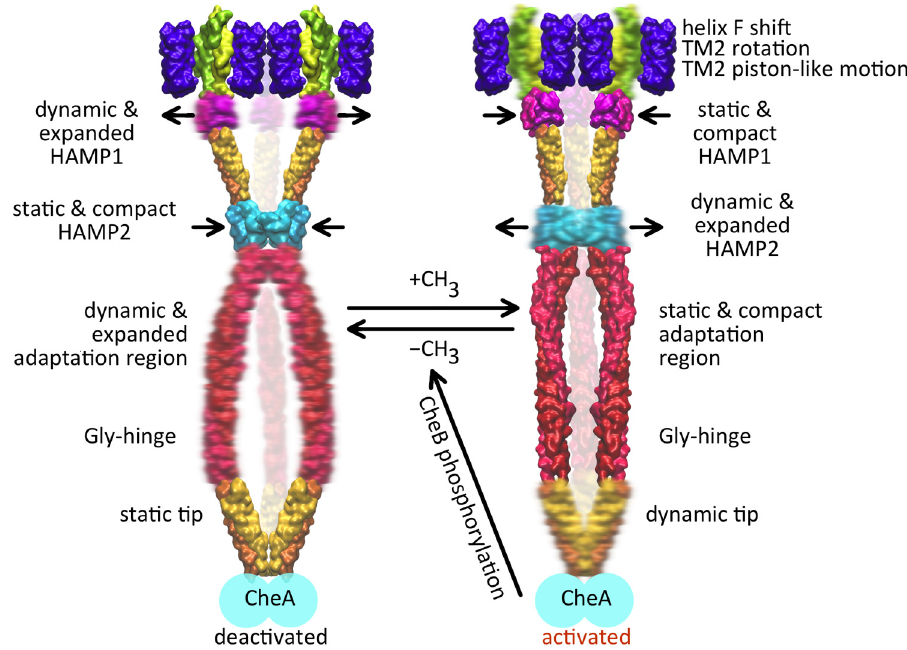
Fig 7. Model for the Np SRII/ Np HtrII complex activation. The regions with higher mobility are shown in diffuse representation; the arrows correspond to the domain motions (compacting/expanding within the